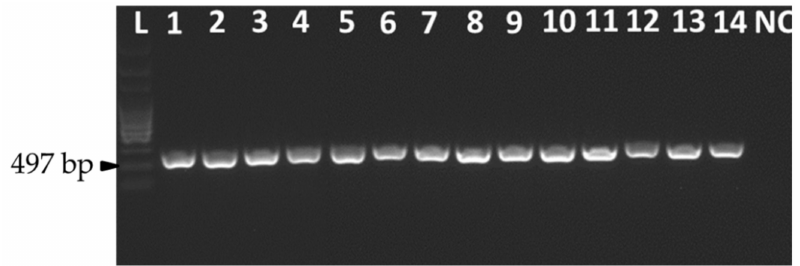
Figure 1. Fungal isolates confirmation targeting the ITS1-5.8S-ITS2 region of A. flavus isolates using the primers FLA1/FLA2. Lanes 1–14 represent isolates, while L is a 100 bp DNA molecular ladder and NC is a negative control (water